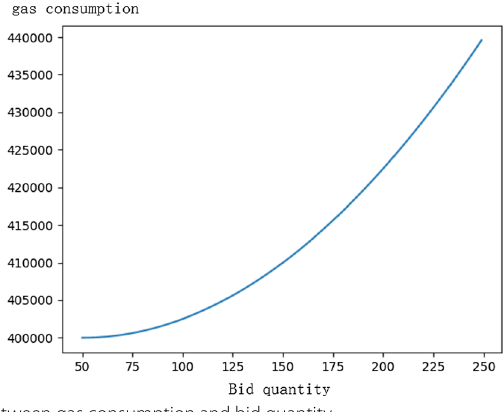
Fig. 5 Relationship between gas consumption and bid